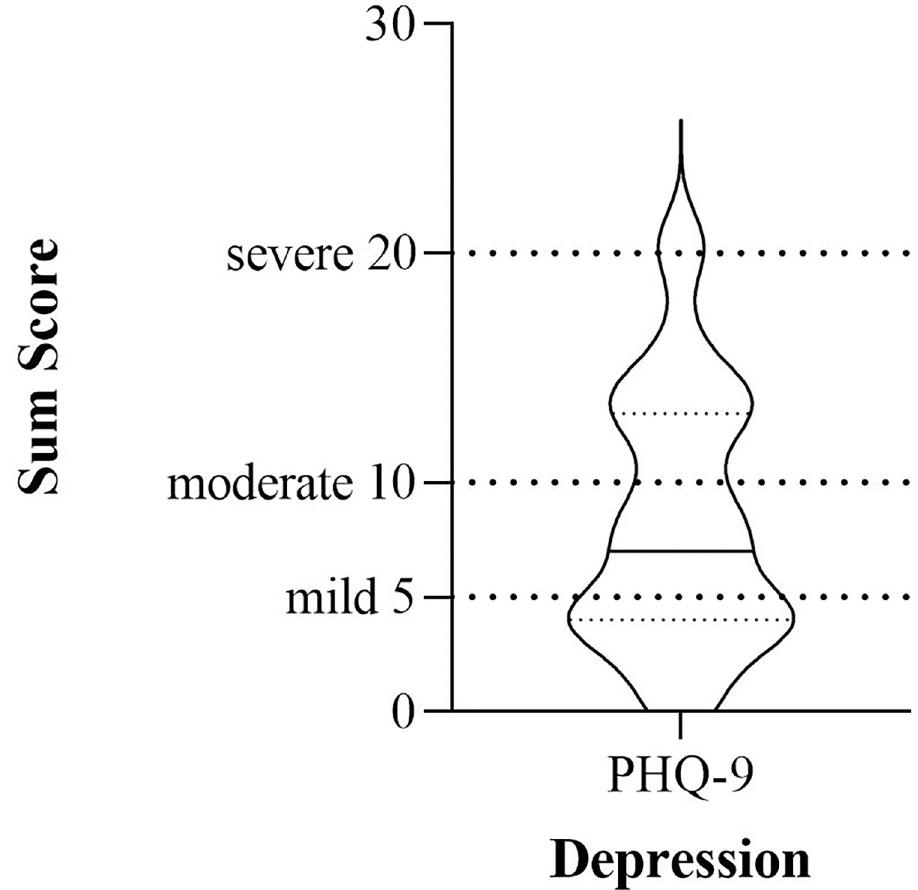
Fig 2. Severity of depression symptoms during and after the first wave of the pandemic. The solid line within the violin plots illustrates the median, and the dashed lines show the interquartile range.